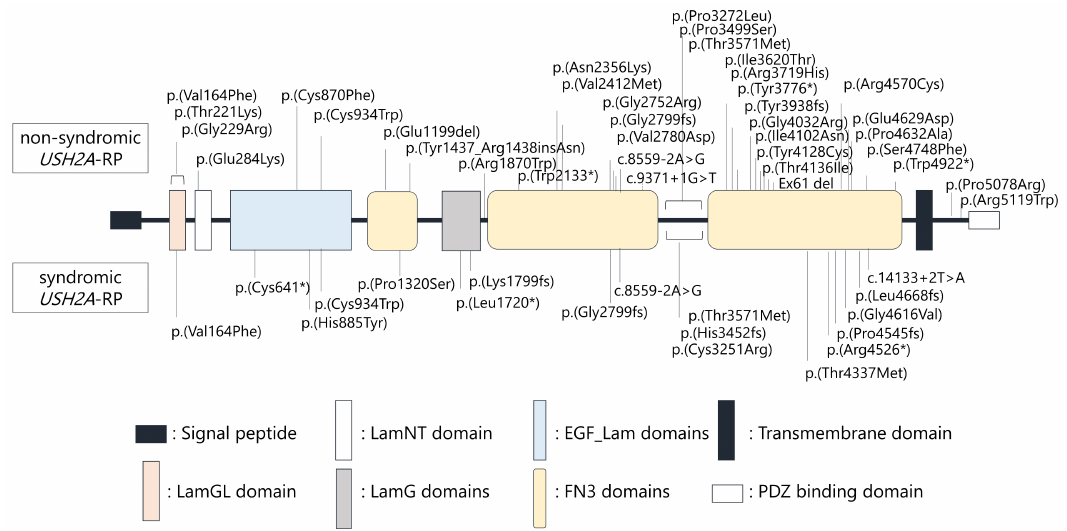
Figure 3. Schematic distribution of the USH2A variants identified in this study. Upper variants were detected in non-syndromic patients ( n = 25), lower variants were detected in syndromic patients ( n = 11). 2.3. Earlier Onset of RP in Syndromic Patients than Non-Syndromic USH2A-RP Patients In order to understand clinical features between syndromic and non-syndromic USH2A -RP, age of disease onset was examined. All syndromic RP patients were aware of symptoms related to RP such as night blindness and constriction of visual field by their third decade of life (Figure 4a). Comparing the onset age of RP in 11 syndromic and 25 non-syndromic USH2A -RP patients, syndromic RP patients were aware of symptoms significantly earlier than non-syndromic patients ( p < 0.05) (Figure 4b). The mean age of onset was 16.1 and 26.5 years old in syndromic and non- syndromic USH2A -RP patients,